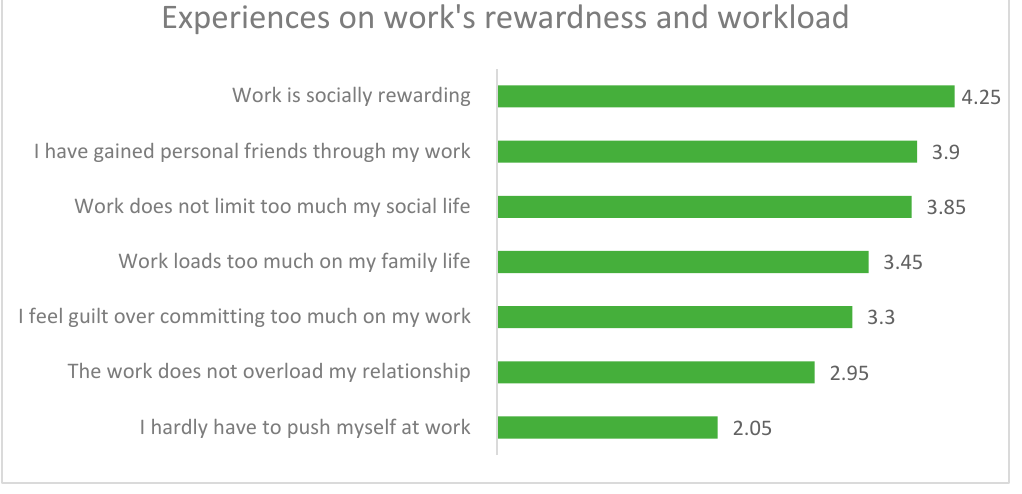
Figure 4. The experiences on work’s rewardness and workload.